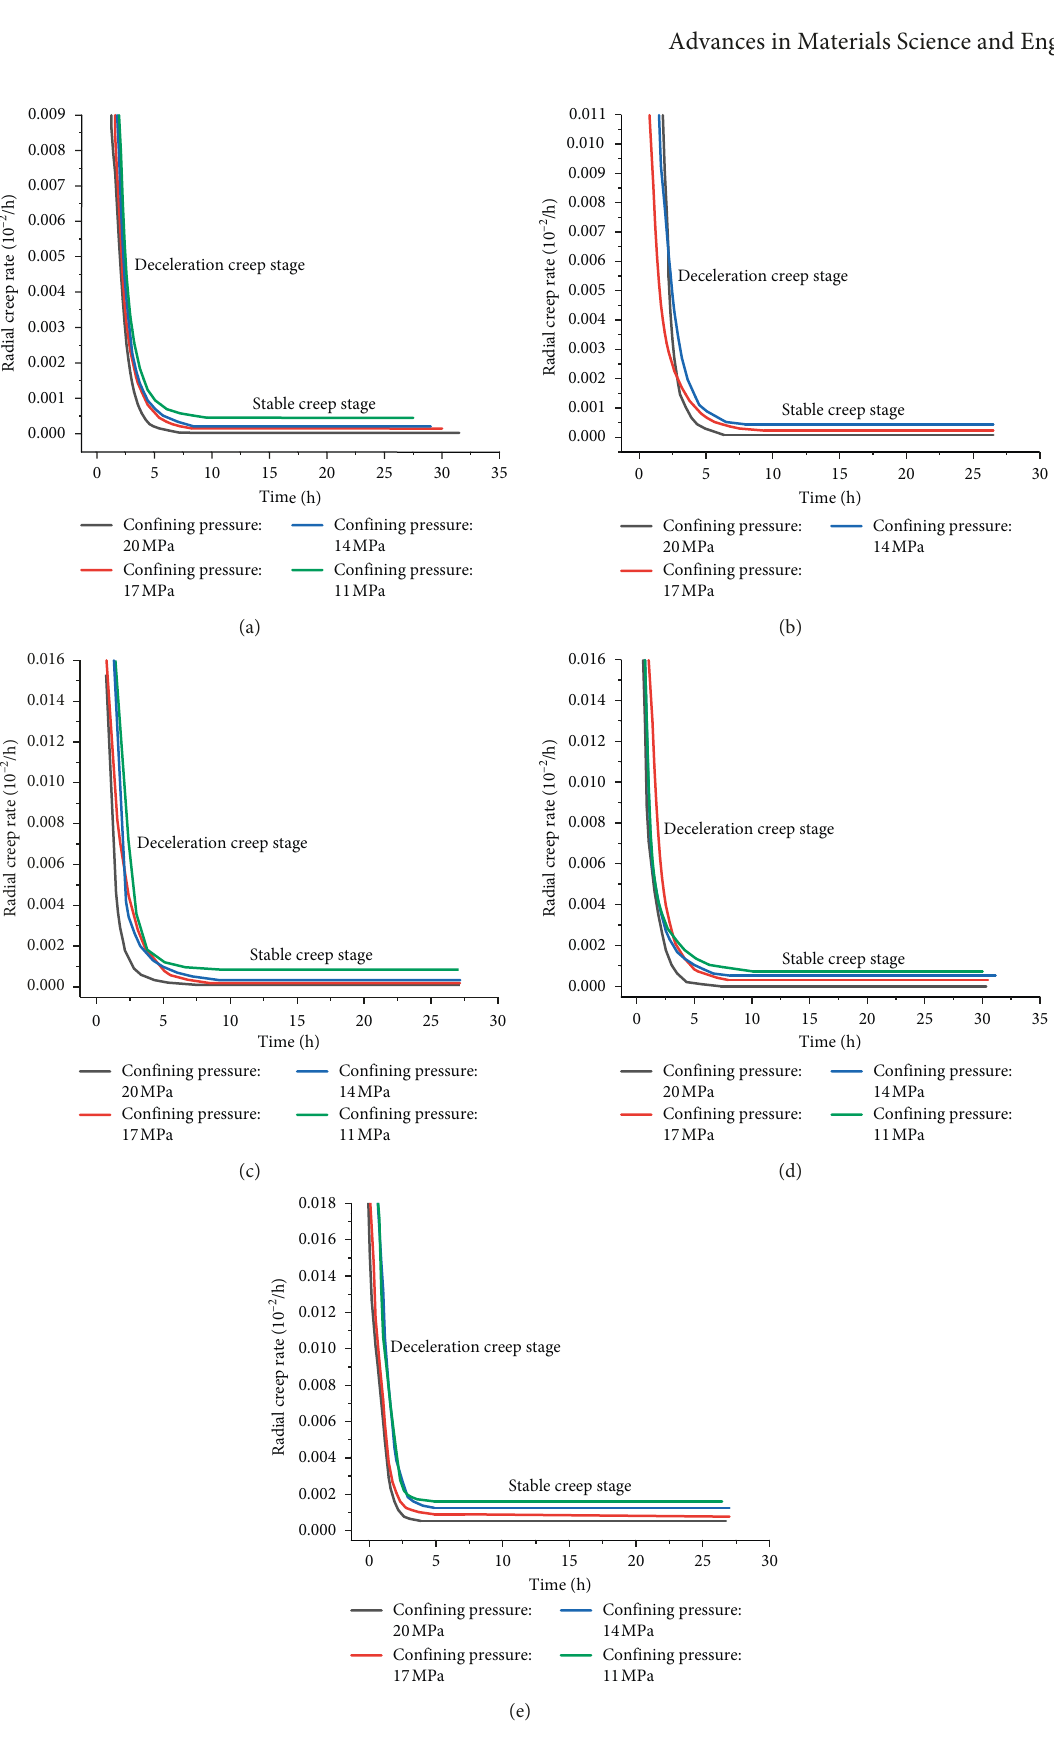
Figure 12: Radial creep rate under different freeze-thaw cycles. (a) T0 specimen. (b) T10 specimen. (c) T20 specimen. (d) T40 specimen. (e) T60